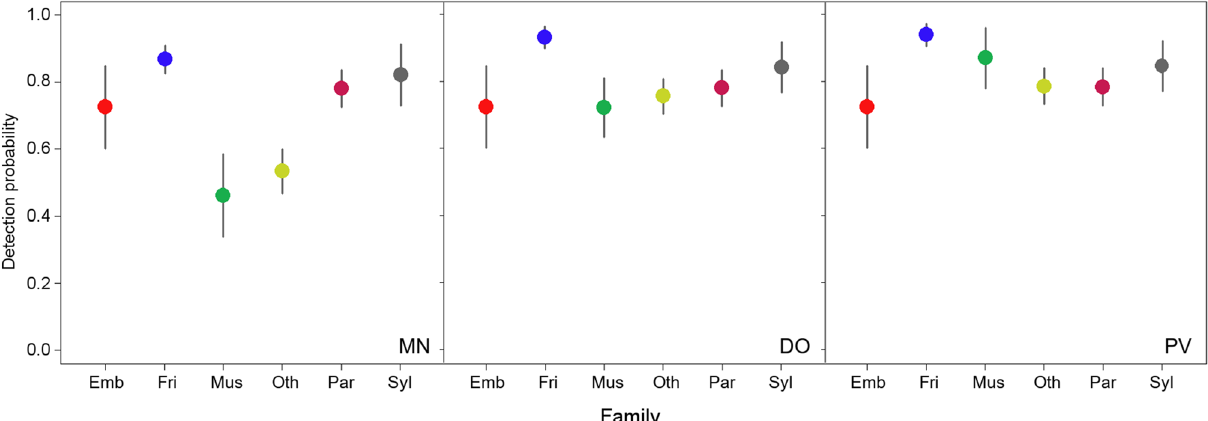
Figure 4. Bird species detectability at family level for each of the three methods deployed in pond surveys in south-eastern Spain. Method-specific, model-averaged estimates of detection probabilities (independent of the survey time) grouped by species family. Vertical lines represent 95% confidence intervals. Only the five families with the highest number of recorded species are indicated, the remaining families being grouped as “other”. Families are indicated as follows: Emb Emberizidae, Fri Fringillidae, Mus Muscicapidae, Oth other families, Par Paridae, and Syl Sylviidae. Survey method label appears in the bottom right corner as follows: MN mist netting, DO direct observation, and PV direct observation plus video monitoring. The figure was created in R (version 4.0.2, https ://www.R-proje ct.org/) and assembled with GIMP (version 2.10.14, https ://www.gimp.org/).